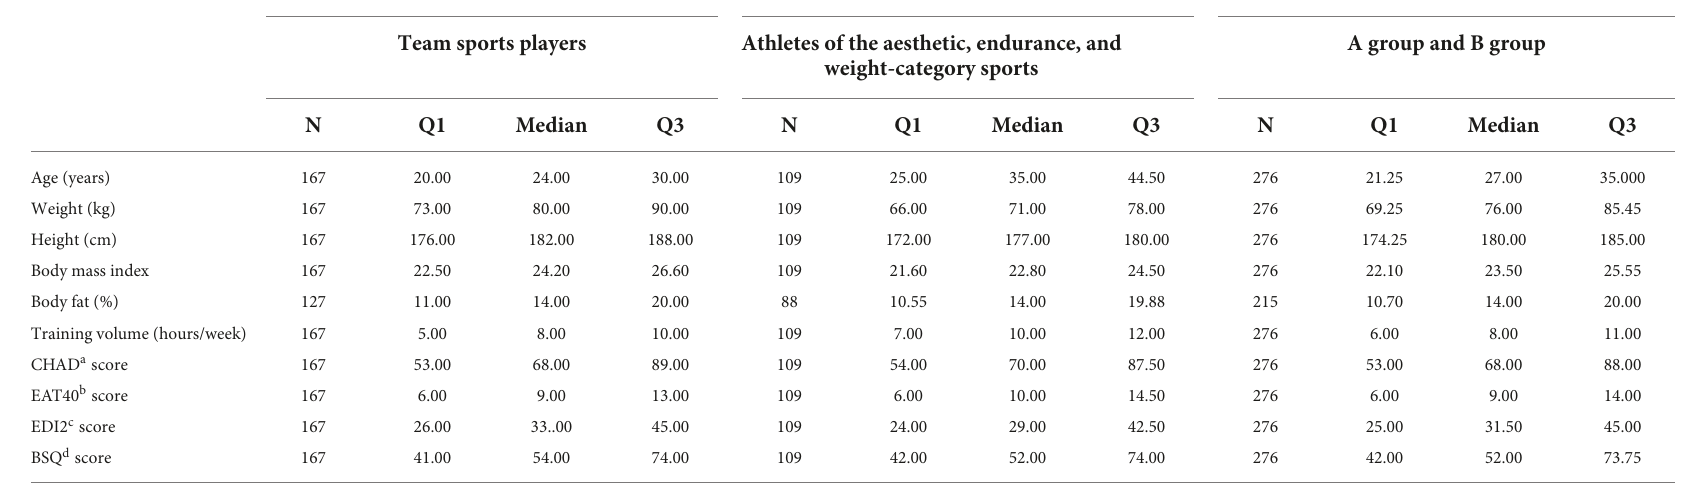
TABLE 1 Sample’s statistical descriptors: characteristics of Spanish team sports players and athletes playing sports categorized as high risk for EDs ( N =